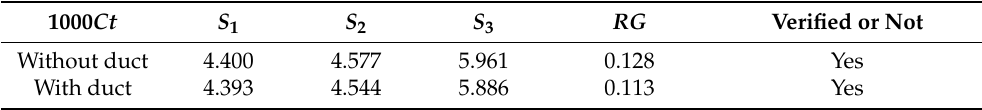
Table 2. Verification result for JBC hull without/with the original